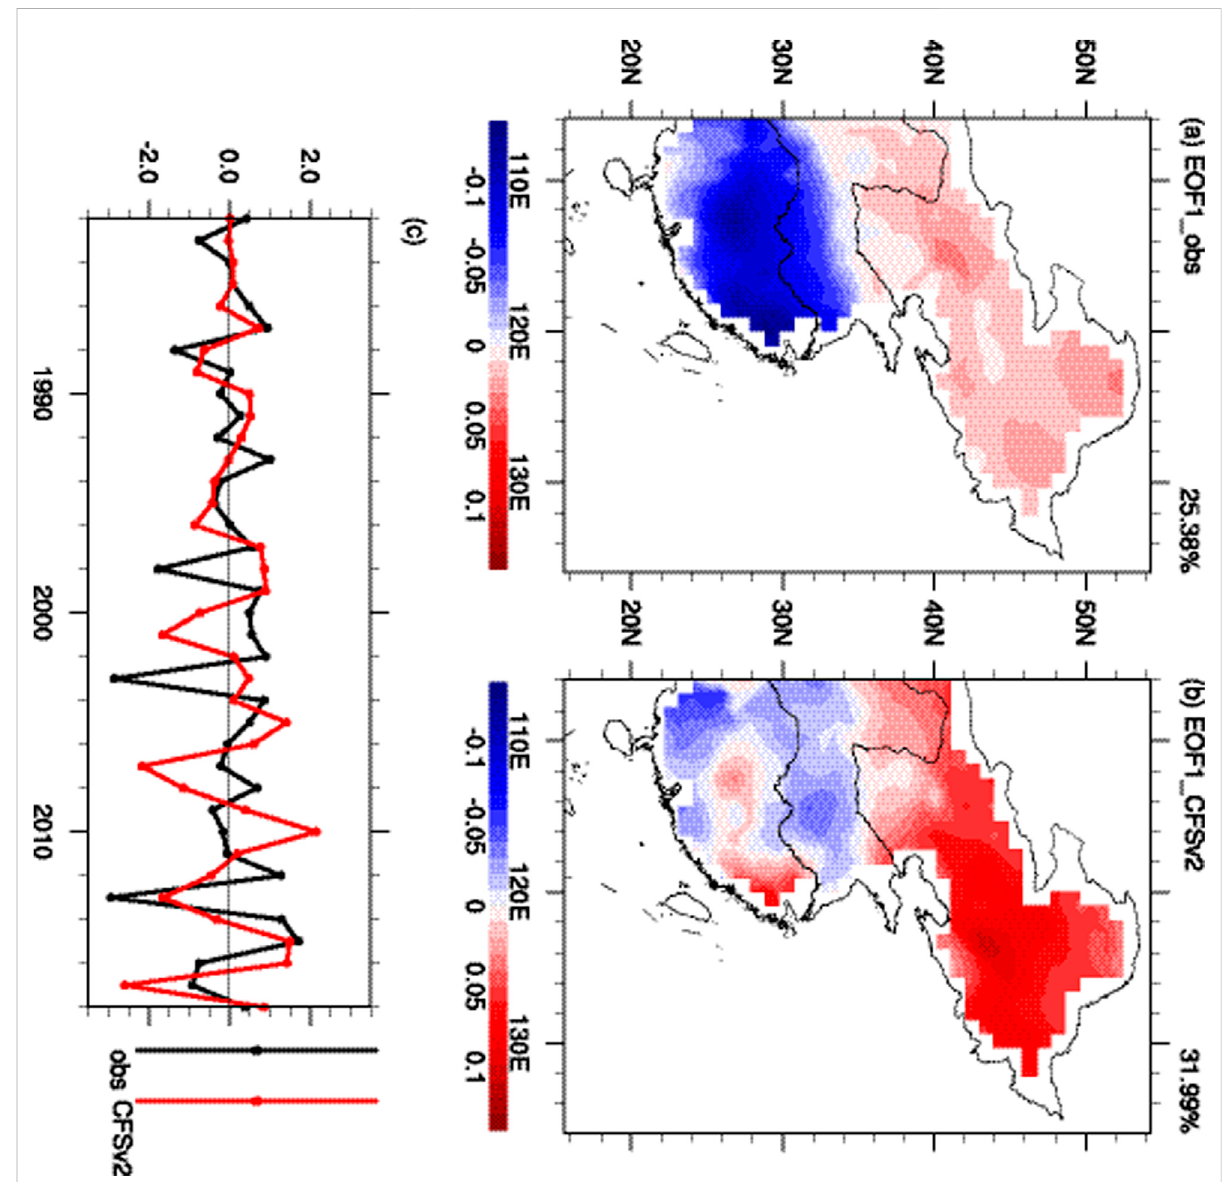
FIGURE 2 First empirical orthogonal function mode (EOF1) of summer FEHEs over eastern China in (A) the observations and (B) the CFSv2 hindcasts. (C) The standardized time series projected to the observed EOF1 of the FEHEs in the observations (black line) and the CFSv2 hindcasts (red line). The percentages in the top-right corner of (A, B) are the explained variance to the total